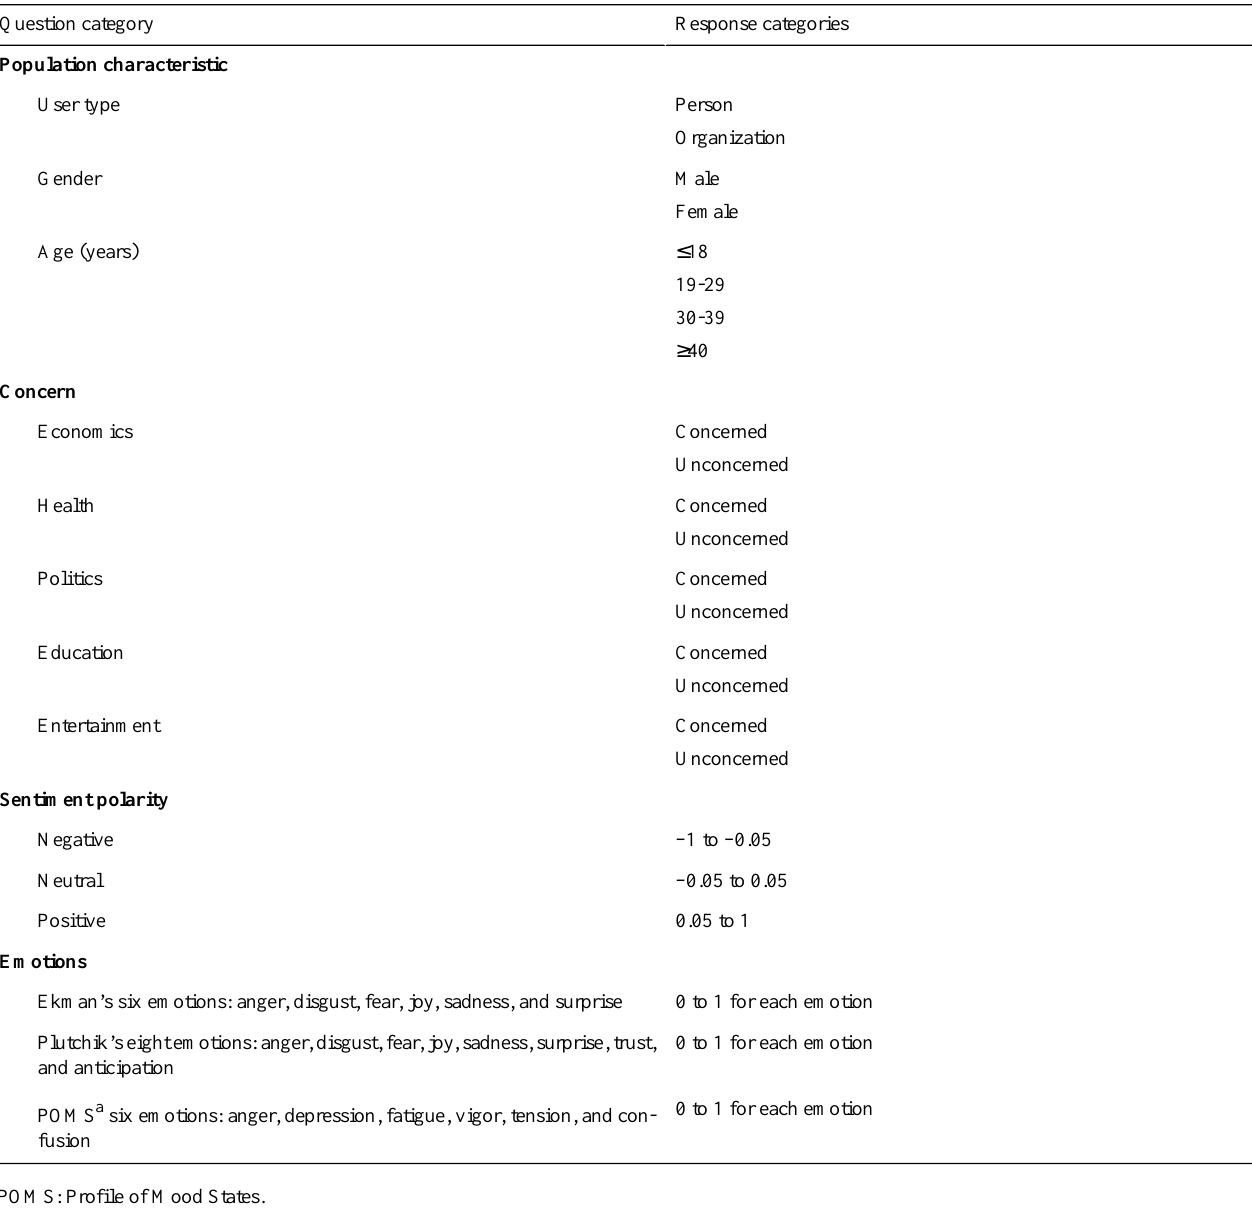
Table 2. The template of the cross-sectional